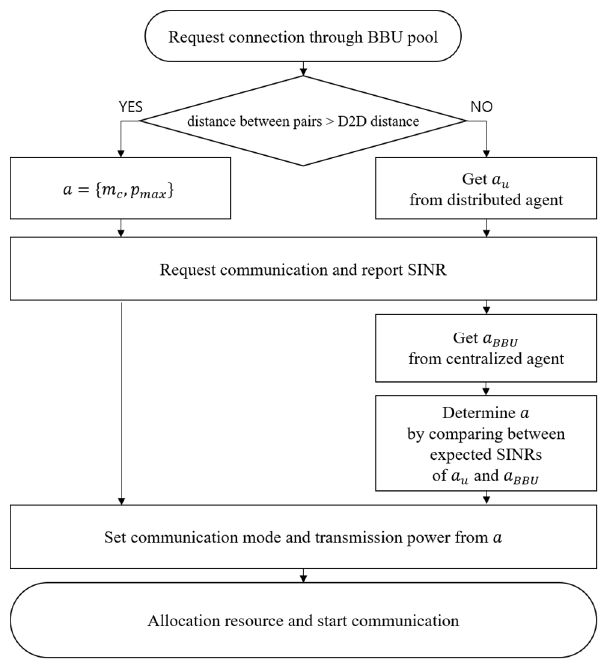
Figure 2. Operation procedure.